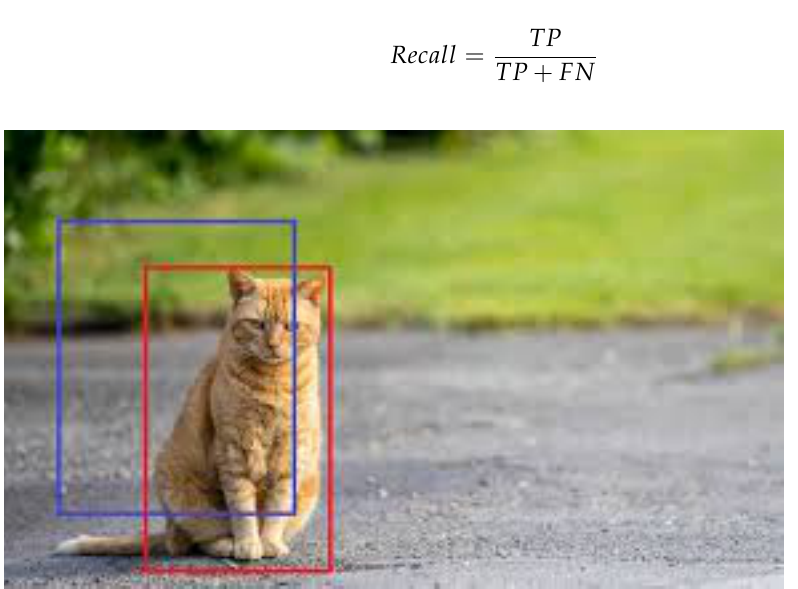
Figure 7. Ground Truth (red) v. Detection (blue) of a cat [44]. ©2019 Soumik